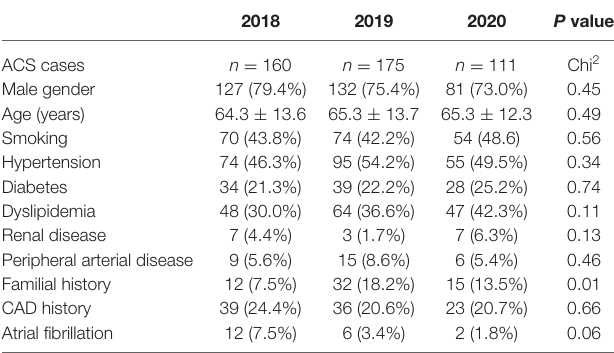
TABLE 1 | Acute coronary syndrome (ACS), events and patient